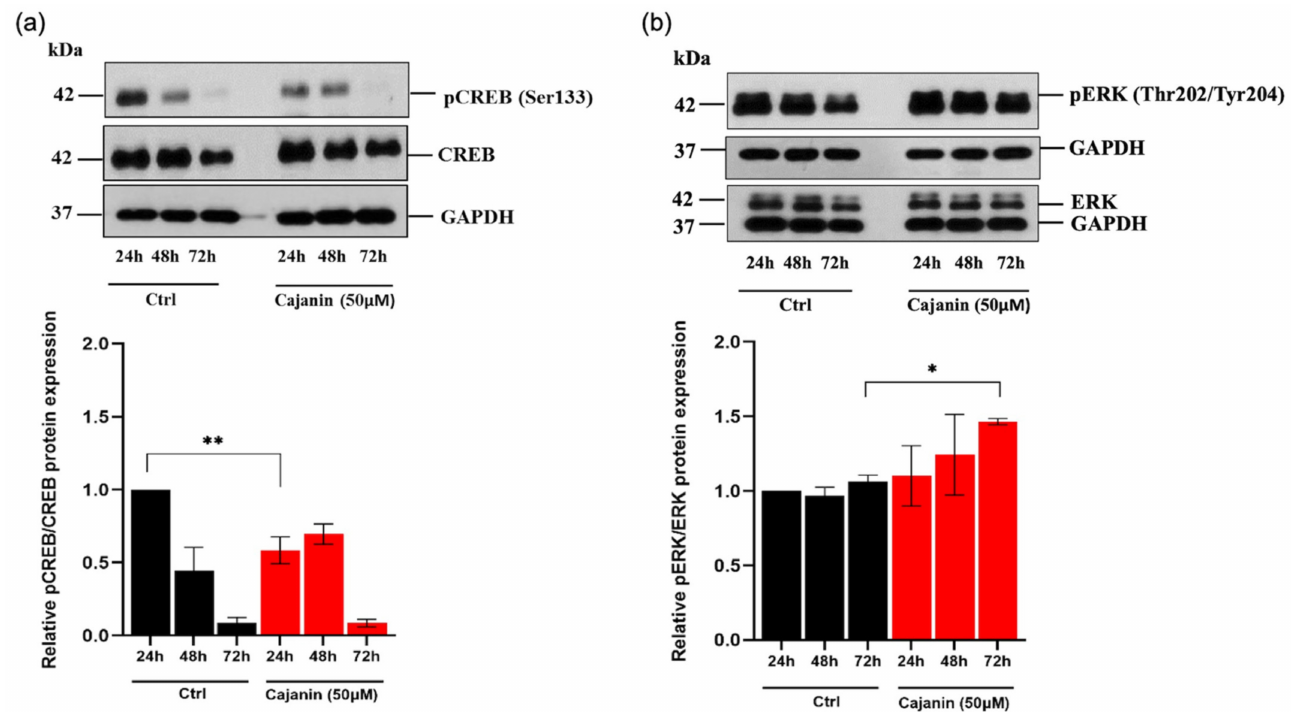
Figure 7. Cajanin regulates signaling molecules mediating MITF expression. ( a ) Suppression on expression level of pCREB/CREB, an upstream signal stimulating MITF transcription was remarkably demonstrated via western blotting in human melanin-producing MNT1 cells cultured with 50 µ M cajanin early at 24 h. ( b ) Treatment with cajanin (50 µ M) for 72 h also obviously augmented level of pERK which moderates MITF expression at a post-translational step. All experiments were performed in triplicate and data are expressed as the mean ± SEM. * p < 0.05, ** p < 0.01 versus non-treated cells